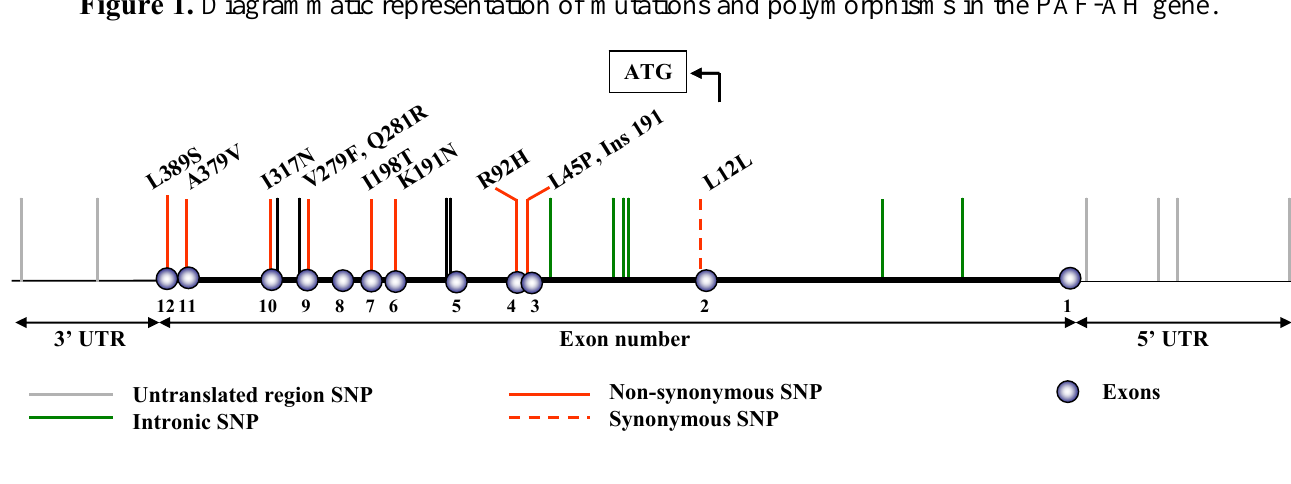
Figure 1. Diagrammatic representation of mutations and polymorphisms in the PAF-AH